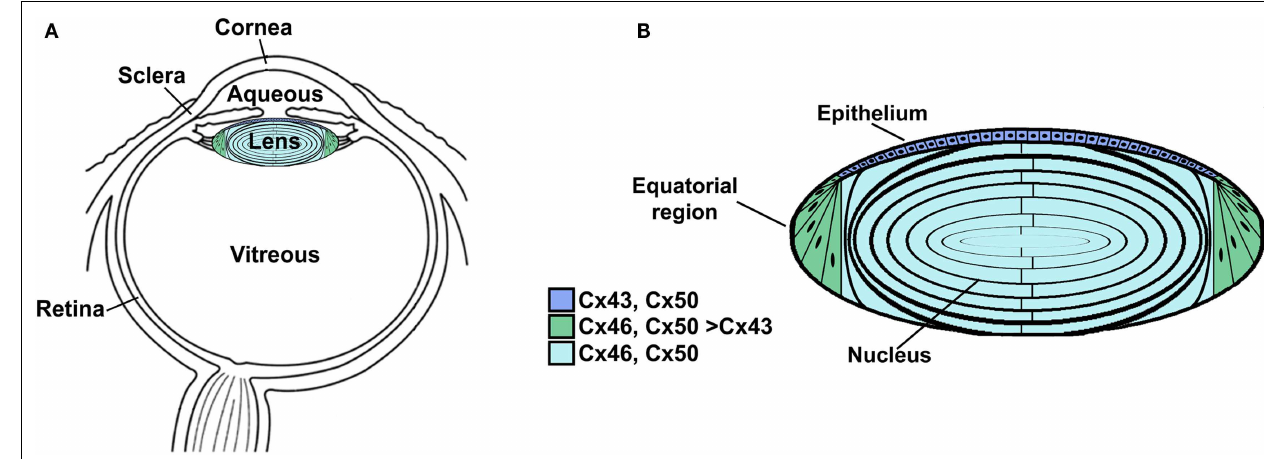
structures of the anterior part of the eye by providing nutrition and removing metabolic products.The vitreous is a viscous, gelatinous liquid that fills the space between the lens and the retina. It is essentially a specialized extracellular fluid containing collagen fibers, hyaluronic acid and other soluble proteins, and glycoproteins.The vitreous is rather stagnant, equilibrating very slowly with the plasma. (B) Diagram of the lens showing the distribution of connexin isoforms. Cells from the anterior epithelial cell layer express Cx43 and Cx50, differentiating fiber cells express Cx43, Cx46, and Cx50, and fiber cells (including those of the nucleus) contain Cx46 and